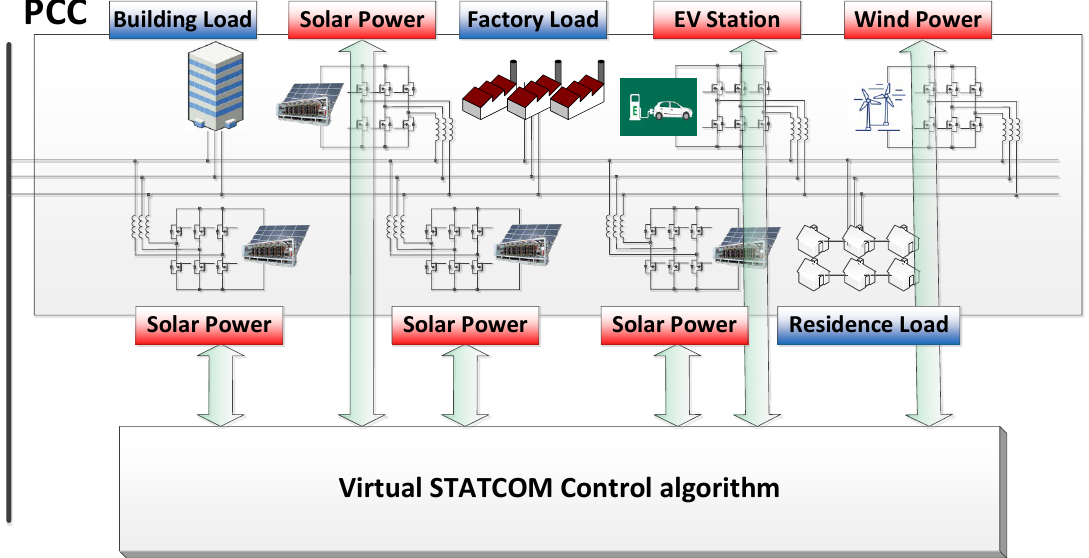
Figure 3. Virtual STATCOM configuration schematic.